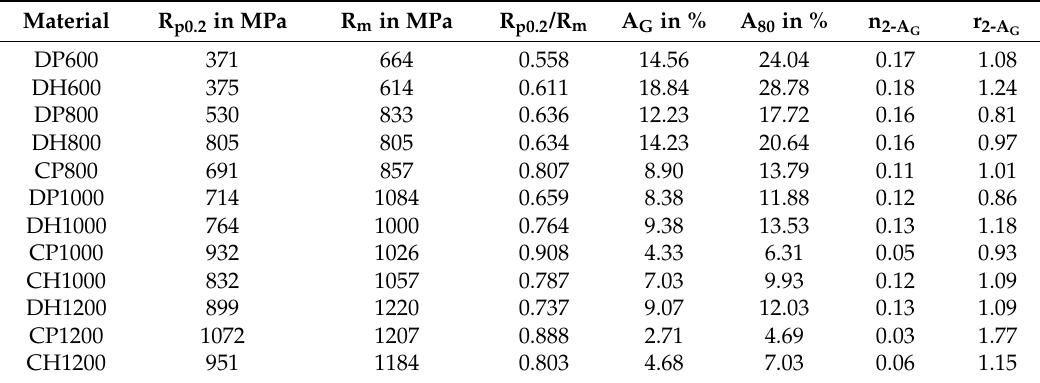
Table A4. Mechanical properties transversal (to rolling) direction